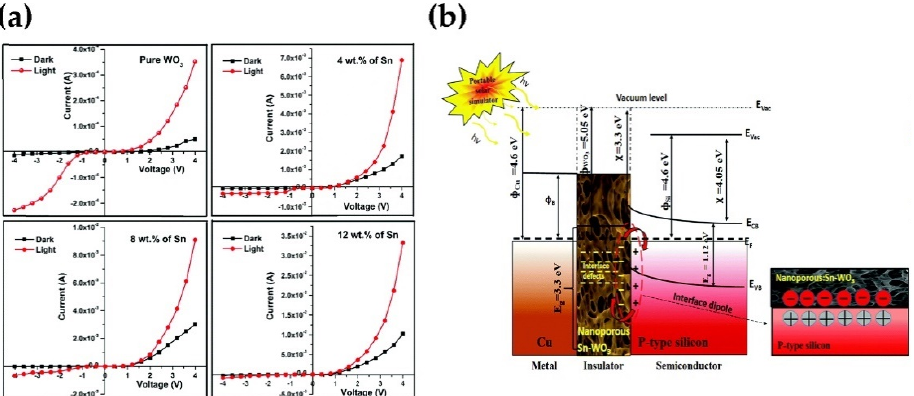
Figure 5. ( a ) I–V characteristics Cu/nanoporous: Sn–WO 3 /p − Si SBDs fabricated with different con- concentrations ( b ) Energy band diagram of the Cu/nanoporous:Sn–WO 3 /p-Si (MIS) type diode. centrations ( b ) Energy band diagram of the Cu/nanoporous:Sn–WO 3 /p − Si (MIS) type diode. Repro- Reproduced or adapted from duced or adapted from [38].